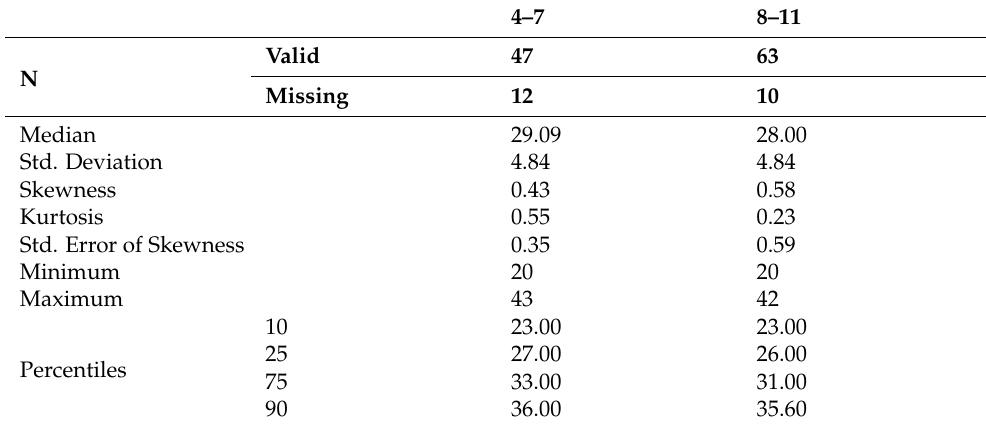
Table 1. Morning/Evening Scale Score for two age groups—parents’ self-report.